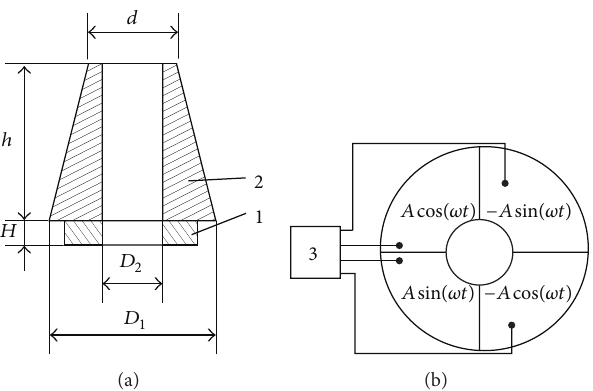
Figure 3: Principle scheme of the cone type actuators (a) and the electrodes topology (b): 1, piezoceramic ring, 2, cone type waveguide, and 3, signal generator.